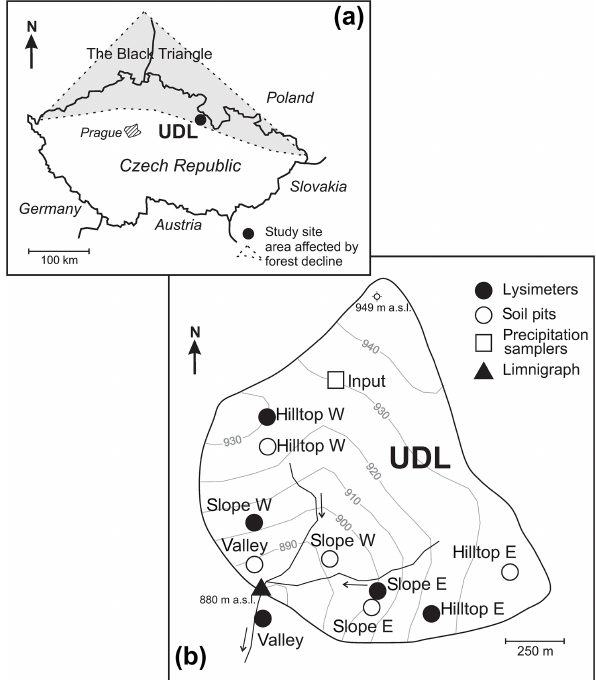
Figure 1. Study site location: (a) the shaded area shows the so- called “Black Triangle”. (b) Sampling